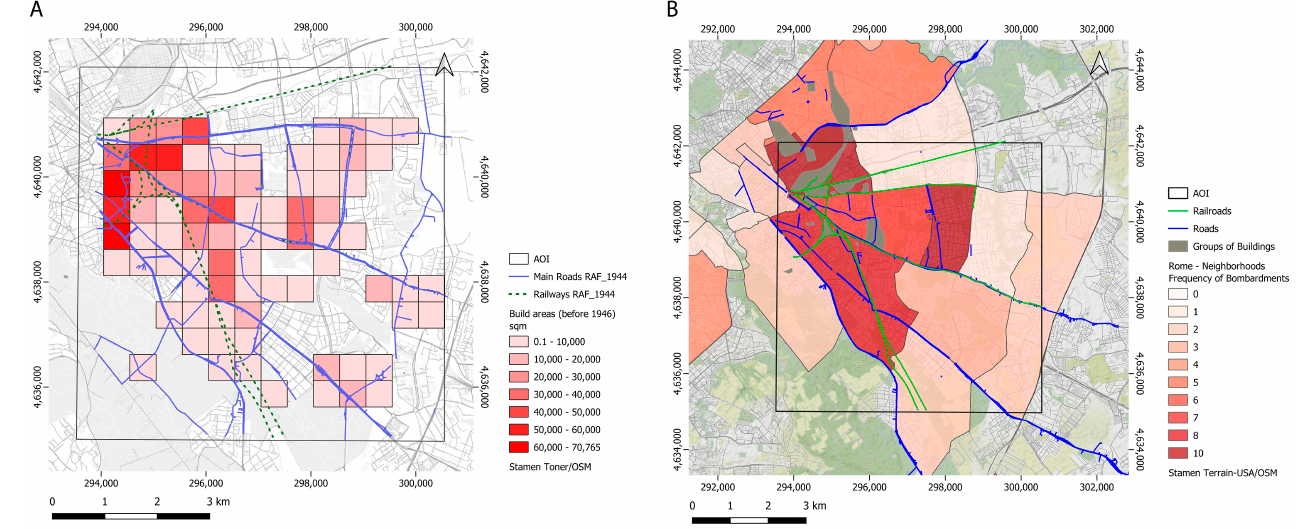
Figure 8. ( A ) Visualization of the denser residential zones in the ‘40s, expressed in square meters per cell, and the contemporary main traffic network (main roads and railways visible in RAF_1944); ( B ) display of the bombing-related vectors Roads and Railroads and Groups of Buildings over the Neighborhoods vector, expressed on the Frequency attribute in the AOI.